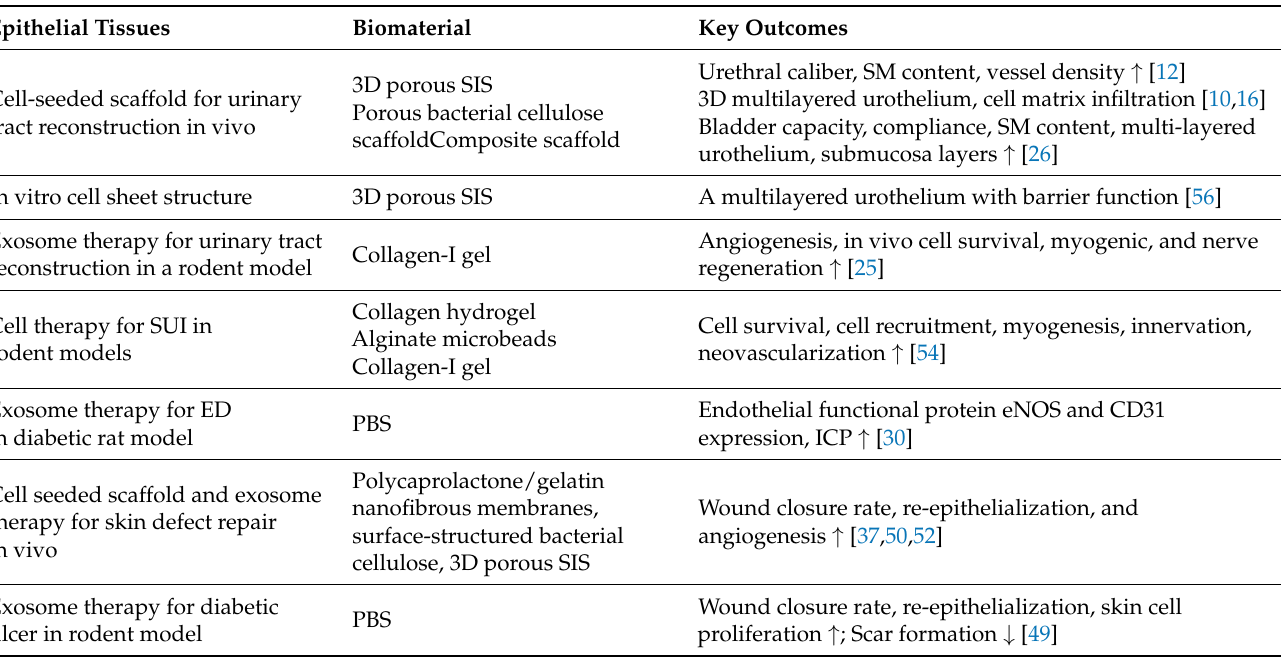
Table 2. Applications of USC in epithelial tissue